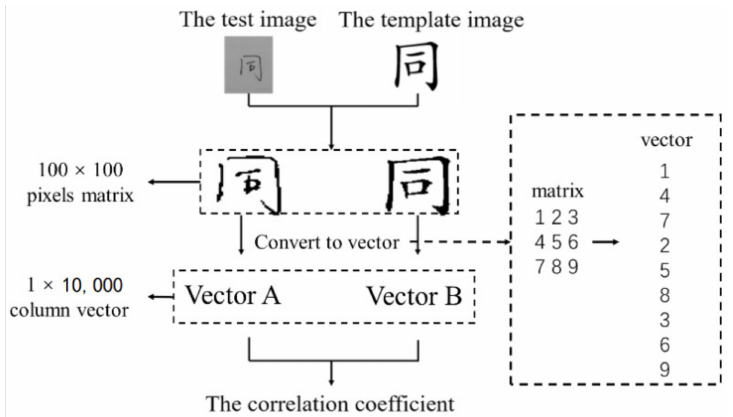
Figure 4. Schematic illustration of correlation coefficient method for Chinese characters “ 同 ” (means